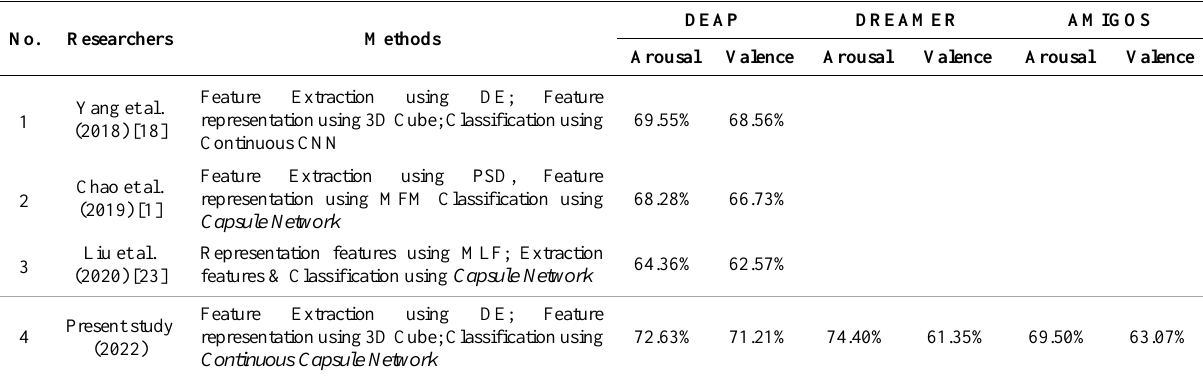
Table 8. Comparison of the accuracy of the Continuous Capsule Network method with several related studies in recognizing two classes of